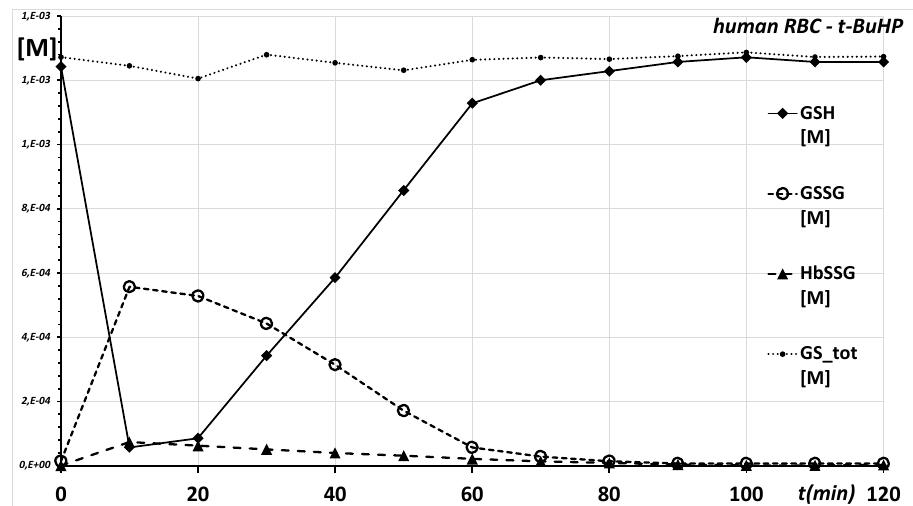
Figure 1. Time course of the concentrations of glutathione (GSH, (cid:7) ), glutathione disulfide (GSSG, ), glutathionyl-hemoglobin (HbSSG, (cid:78) ) and total glutathione (sum of the preceding, • ) in the experiment performed by Colombo et al. [47]. Data have been retrieved, recalculated and replotted from the figures in the original article. Recalculated raw data are reported in tabular form in Appendix A.